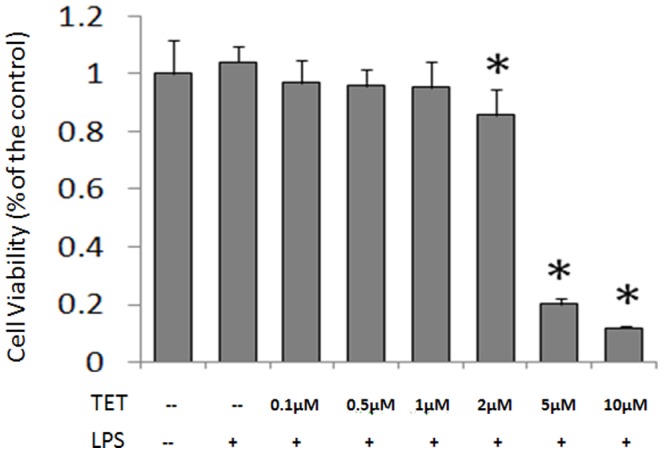
Effect of TET on the cell viability of BV2 cells.BV2 cells were treated with TET at various concentrations for 2 h. Then, LPS was added to each well and incubated at 37°C for an additional 24 h. Cell viability was measured by CCK-8 assay. Results were expressed as a percentage of the control cultures and the mean ±S.D. from three independent experiments performed in triplicate. * P<0.05 compared with the LPS (−) TET (−) group.